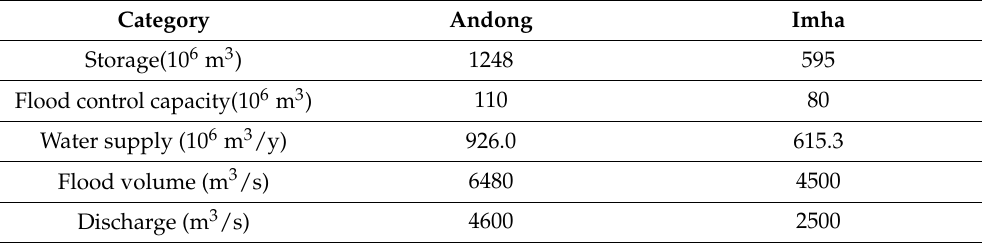
Table 1. General status of Andong and Imha Dams.